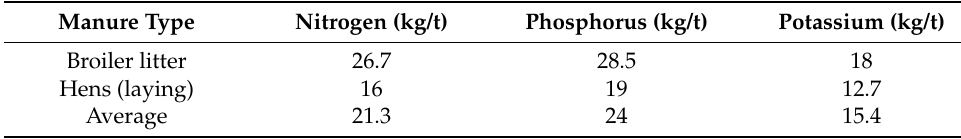
Table 4. Average nutrient content per ton of